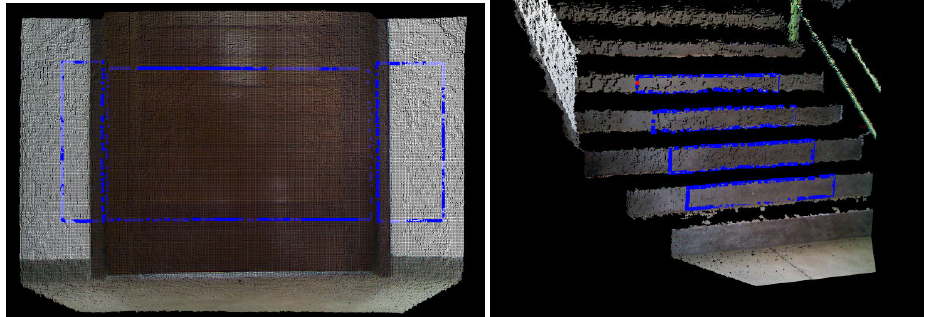
Figure 3. Images resulting from the segmentation